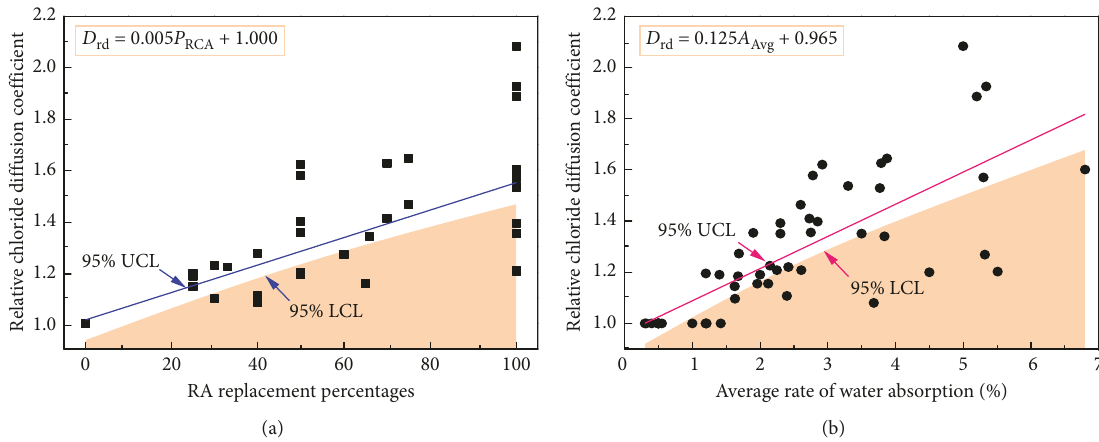
Figure 5: Chloride permeability of concrete with (a) various RA contents and (b) various average water absorption rates [69, 76–88].